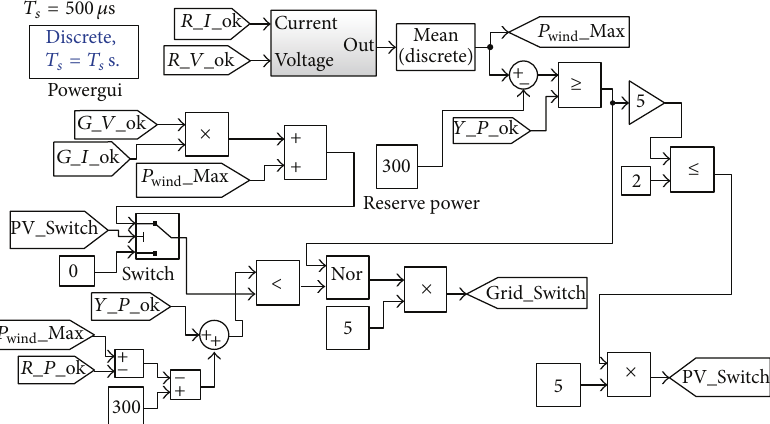
Figure 19: Simulink model of the proposed power management system.